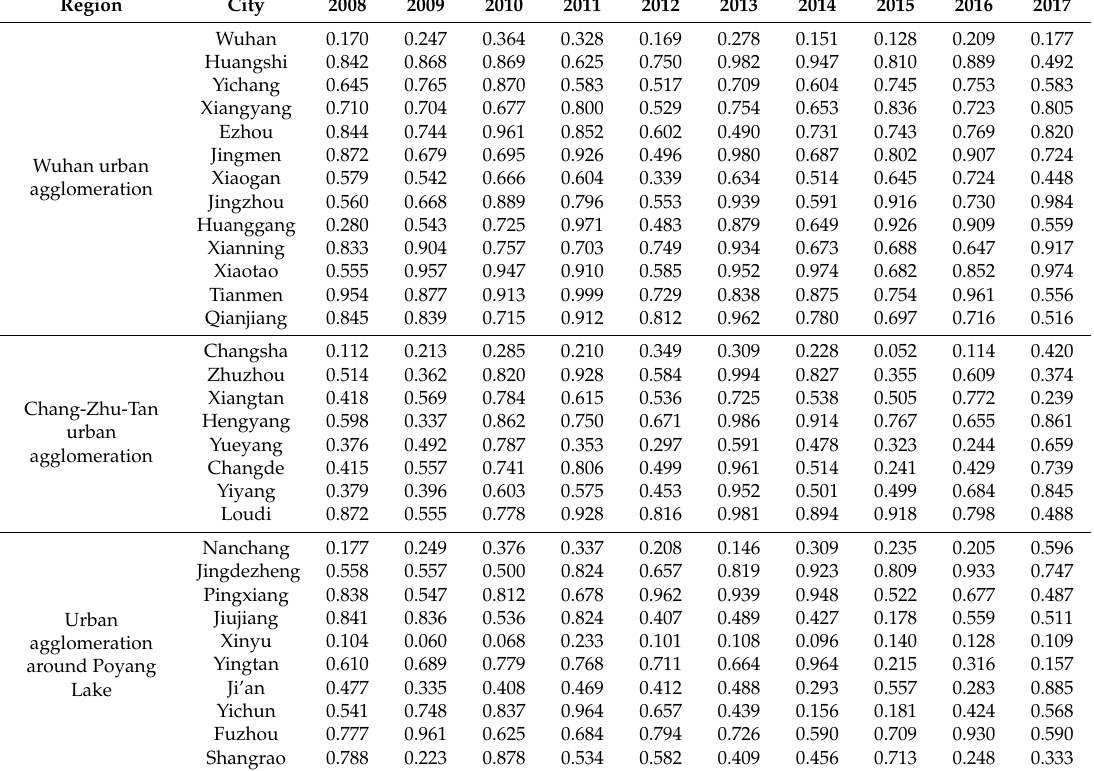
Table 4. Static coordination degrees of the WRES and the HQEDS of the urban agglomeration in the middle reaches of Yangtze